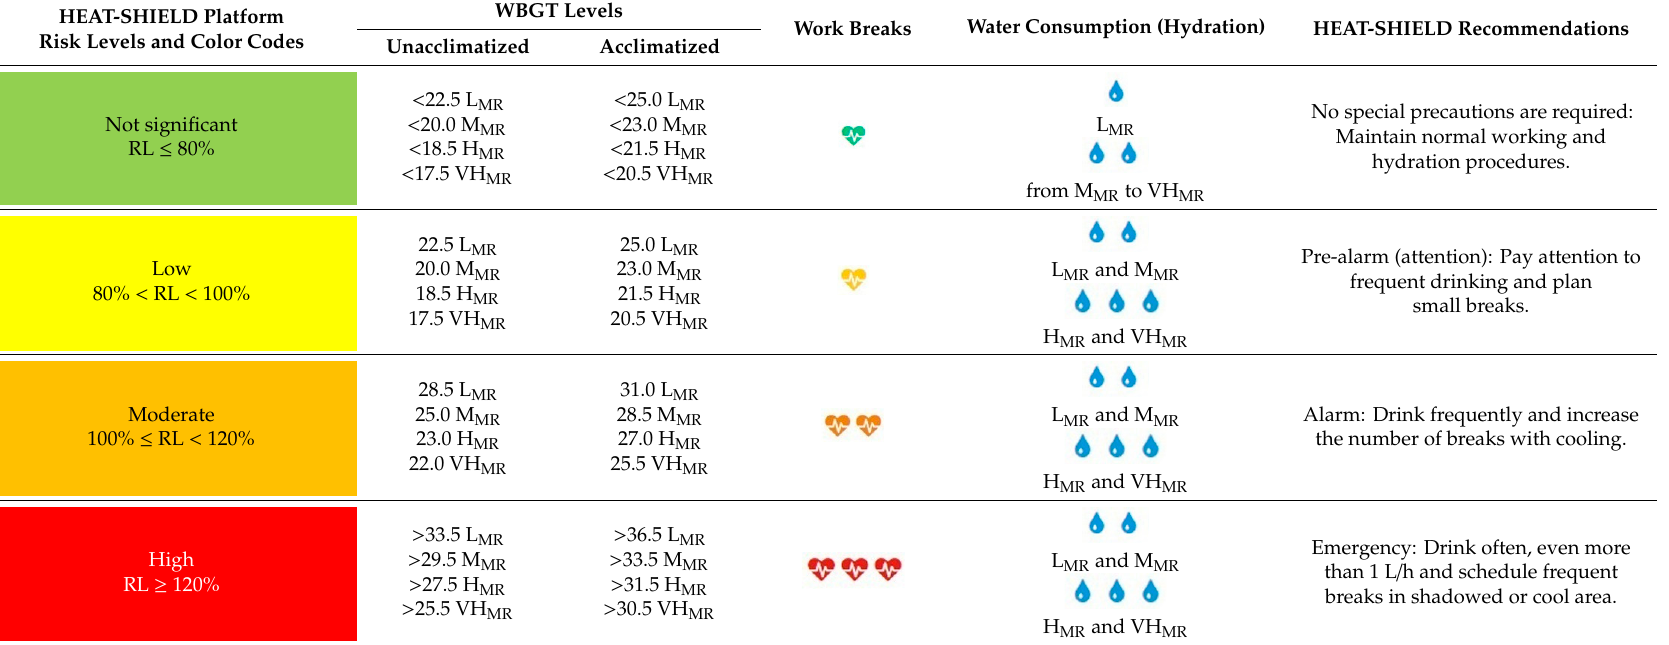
Table 1. The characteristics of the HEAT-SHIELD platform risk levels.